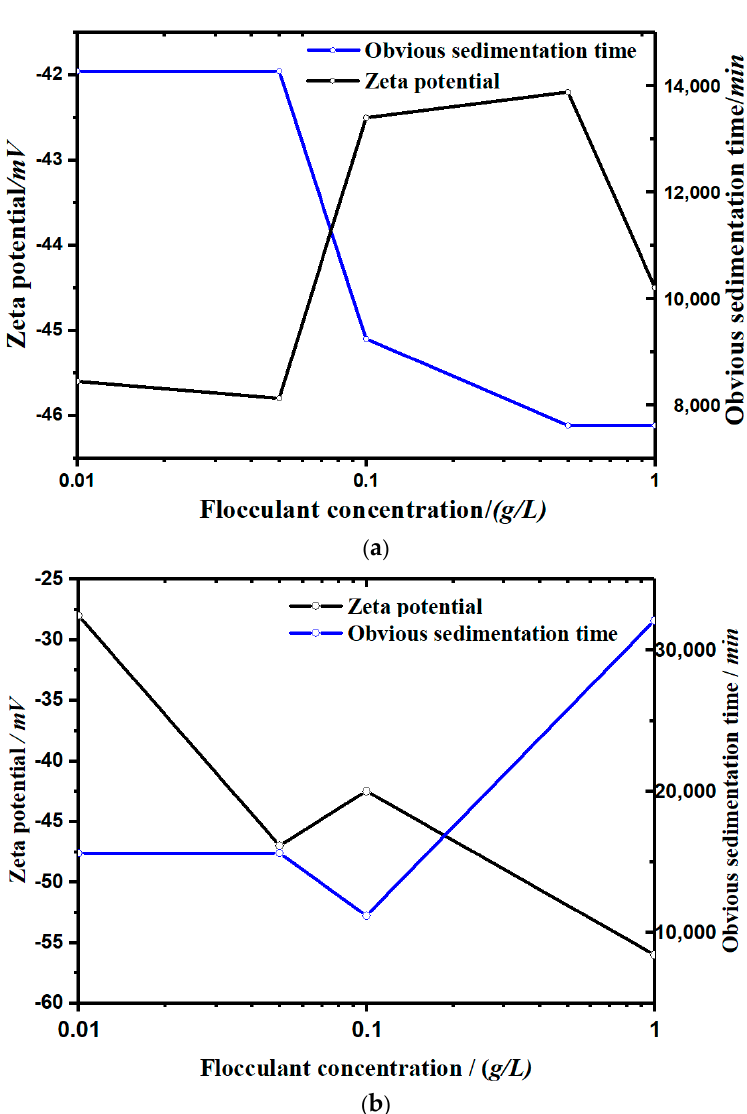
Figure 5. The zeta potential corresponding to the obvious sedimentation time in each concentration group: ( a ) with a soluble starch flocculant and ( b ) with an apple pectin group: ( a ) with a soluble starch flocculant and ( b ) with an apple pectin flocculant. Through experiments, the following were found: